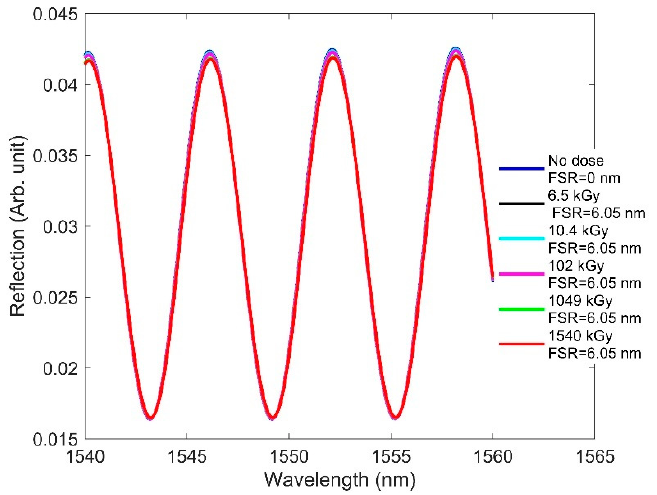
Figure 9. RIC effects on the interferometric fringes of the designed F-P when the dose is increased from 0 to 1540 kGy, where FSR is the spectral distance between two adjacent fringe peaks for a given radiation.